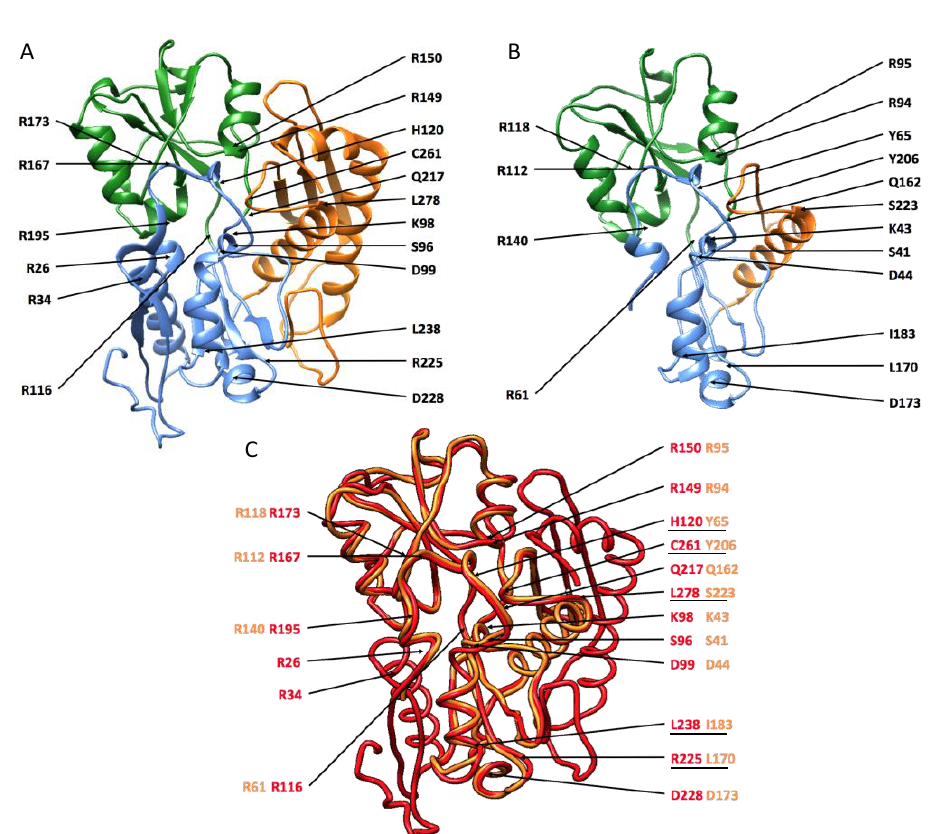
Figure 5. Enzymatic structure and homology modeling for human PBGD ( A ) and P. margaritifera PBDG_A ( B ). Domain one is shown in blue, domain two in green, and domain three in orange. Key residues are labeled, as are their positions in the primary structure. ( C ) Superimposition of P. margaritifera PBGD_A (in orange) on human PBGD (in red). Positions of key residues for each enzyme are indicated, and amino acid substitutions are underlined.